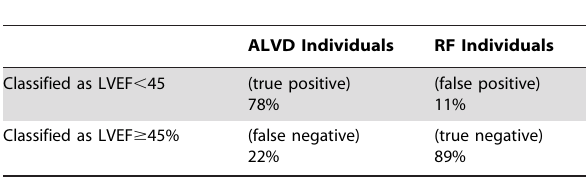
Table 2. Leave-one-out’s confusion matrix.